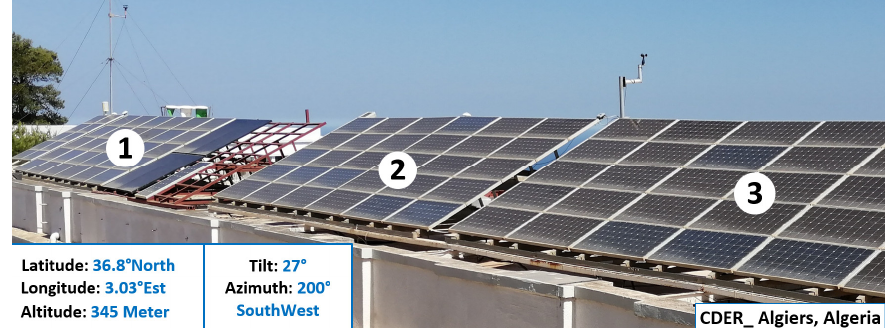
Figure 2. Picture of the grid connected rooftop PV system installed at CDER.